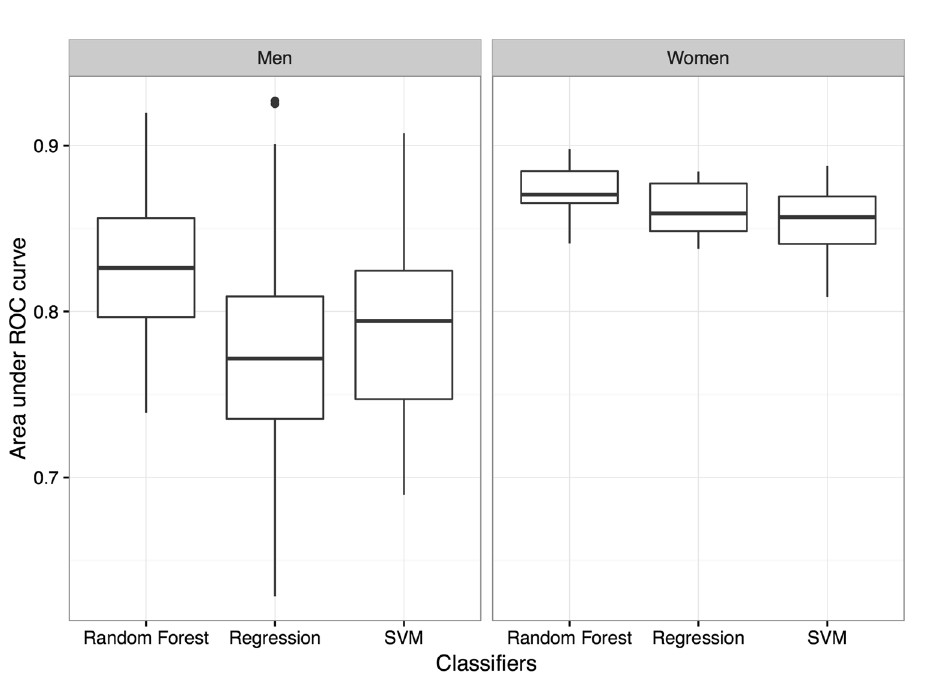
Figure 1. Performance of classification models constructed using random forest, linear regression, and SVM classifiers. ROC: Receiver operating characteristic, SVM: Support vector